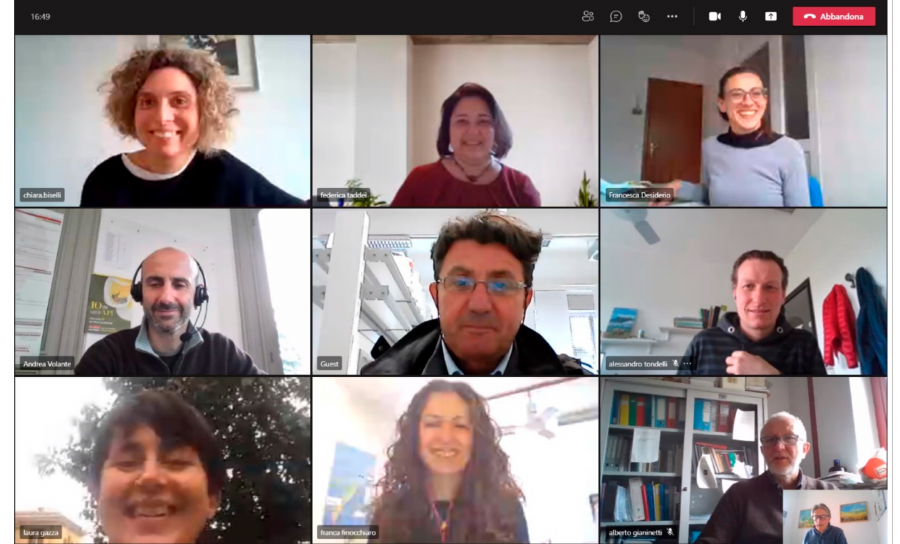
Figure 4. Chiara Biselli, Federica Taddei, Francesca Desiderio, Andrea Volante, Giampiero Val è , Alessandro Tondelli, Laura Gazza, Franca Finocchiaro, Alberto Gianinetti and Luigi Cattivelli (small picture) (from up to down and from left to